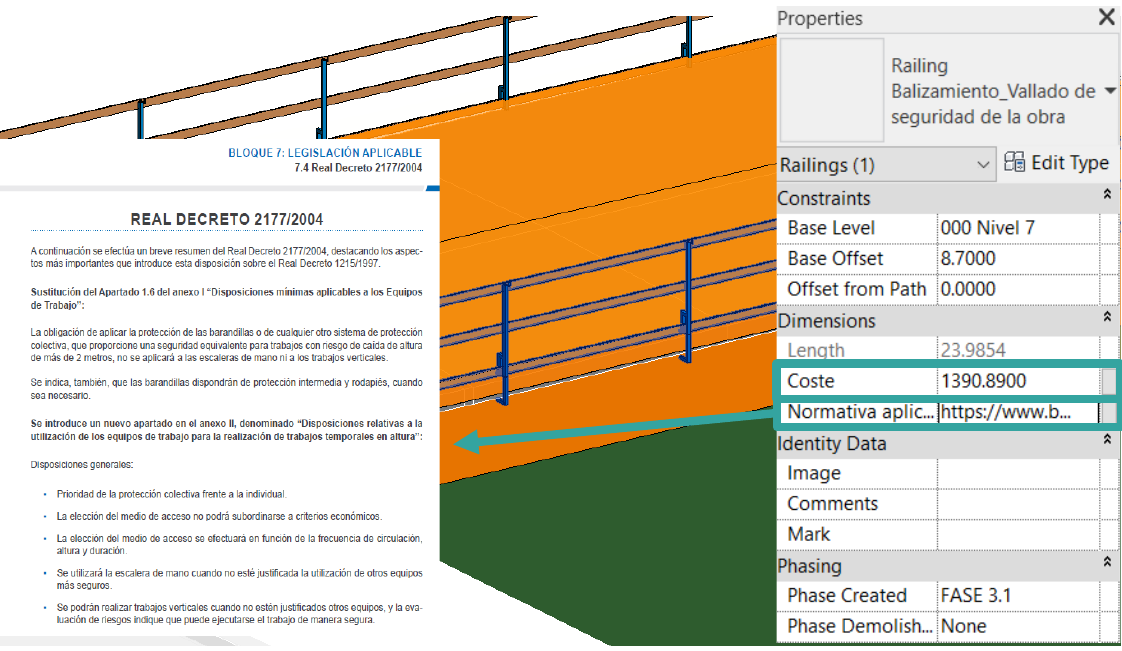
Figure 12. Association of auxiliary information with preventive measures.